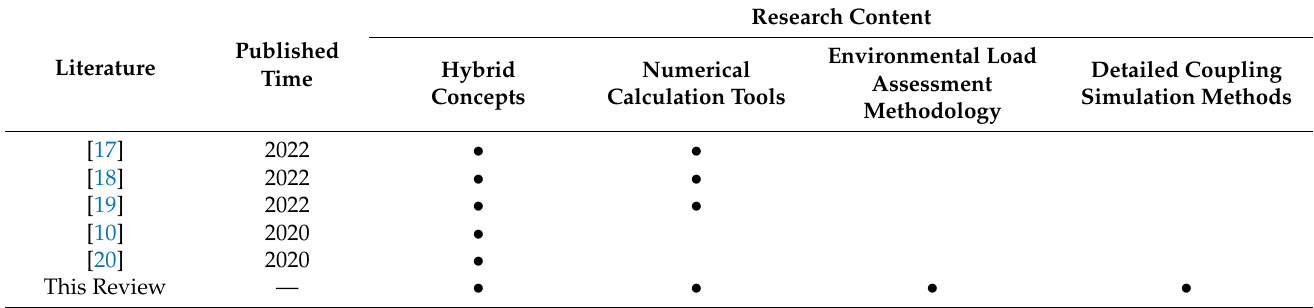
Table 1. The research content of different reviews in the domain of